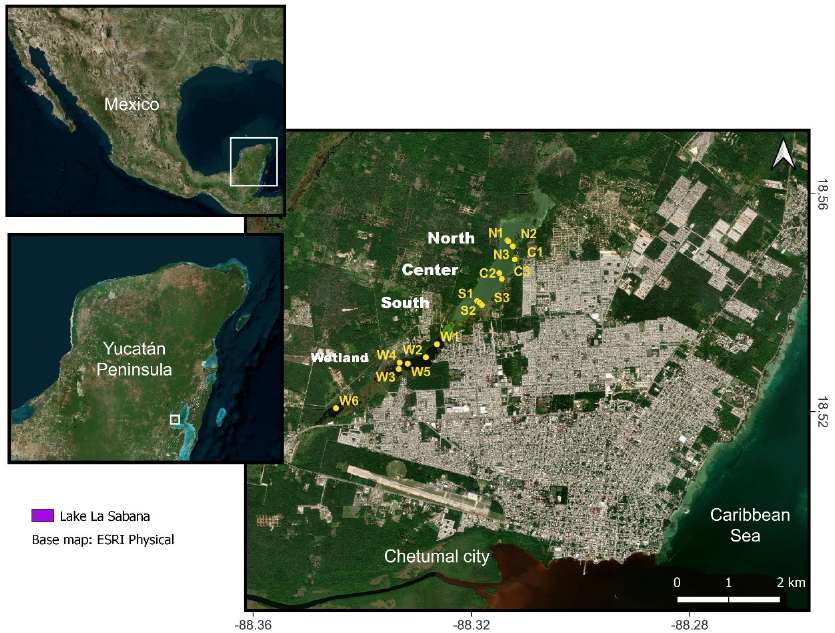
Figure 1. Satellite map showing the geographical location of Lake La Sabana. Yellow dots represent sampling sites in the north (N), center (C), south (S) and wetland